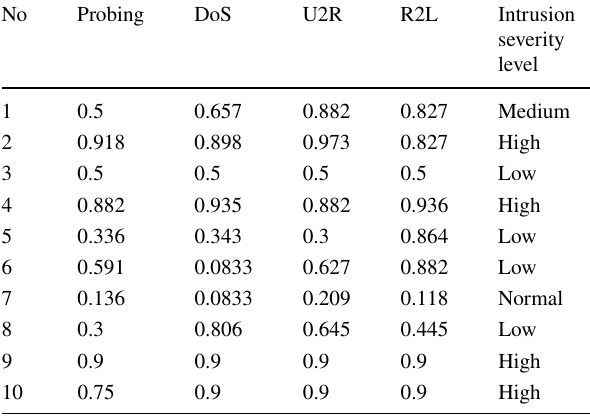
Table 16 Rule viewer adjustment for intrusion classification No Probing